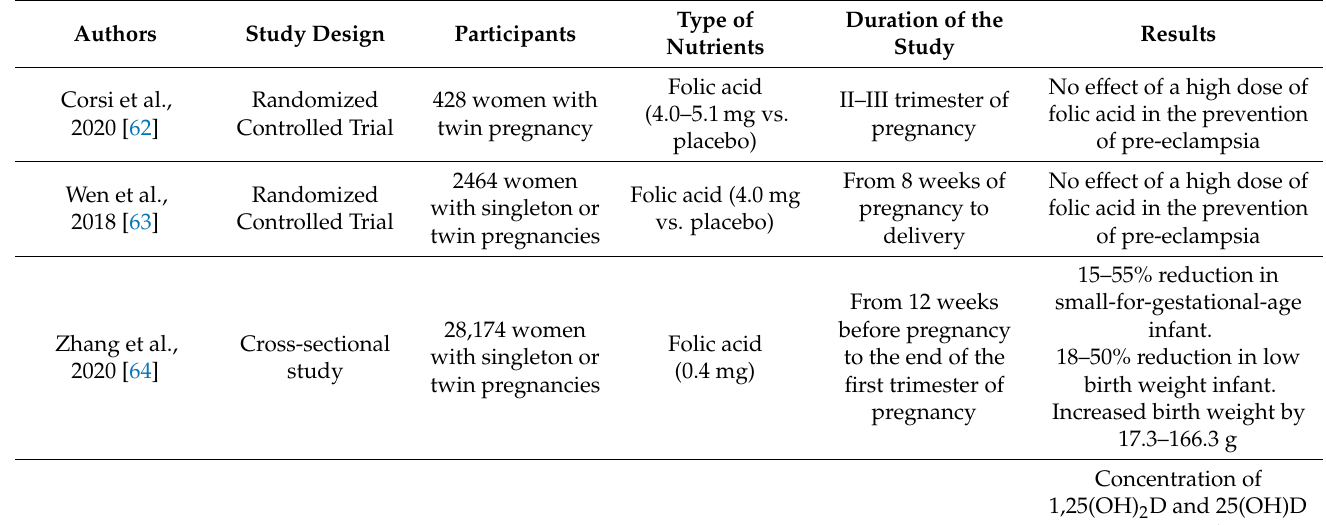
Table 1. Characteristics of studies on the concentration of nutrients and their supplementation in women pregnant with